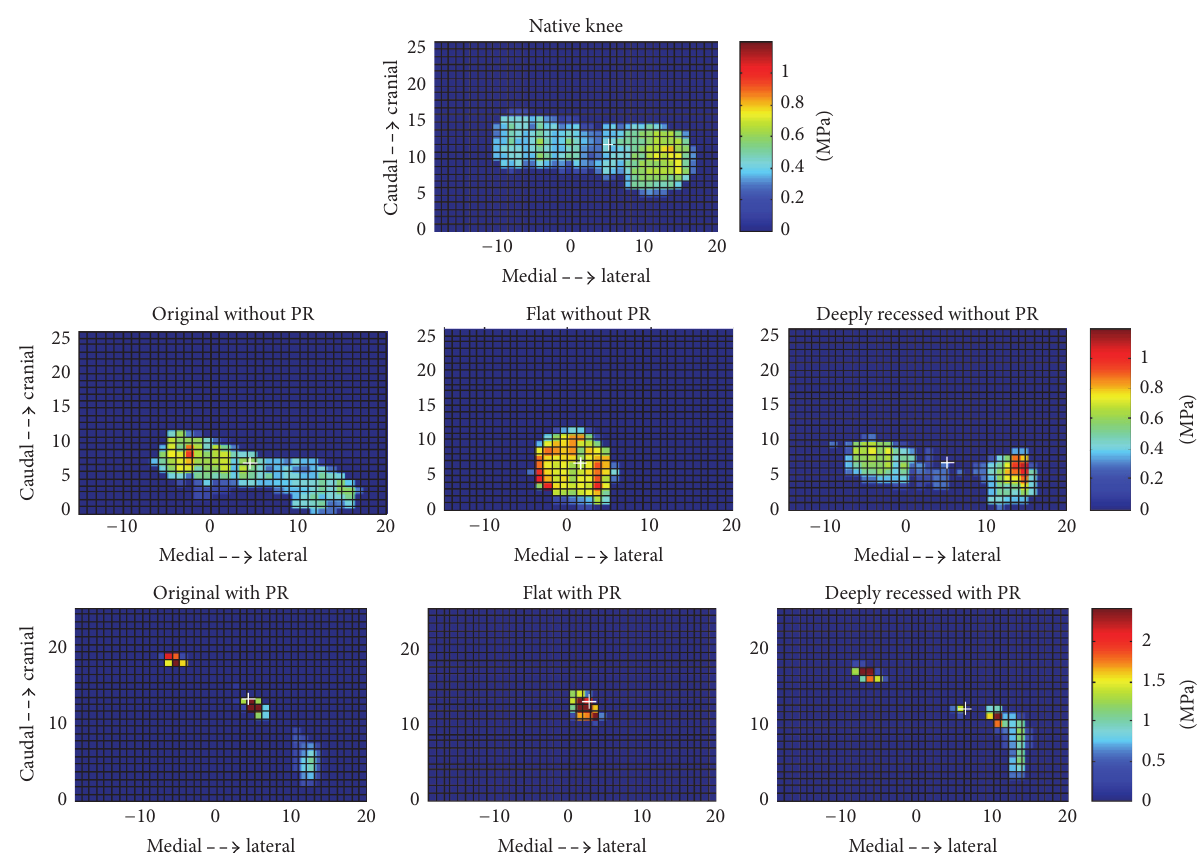
Figure 5: Example of pressure profile for the designs: native knee, original Genesis II design, flat design, and both sides elevated (deeply recessed), respectively, with and without additional patellar resurfacing (PR).